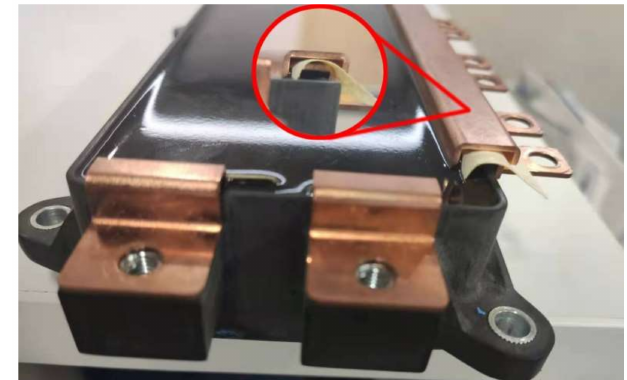
Figure 4. Capacitor with laminated